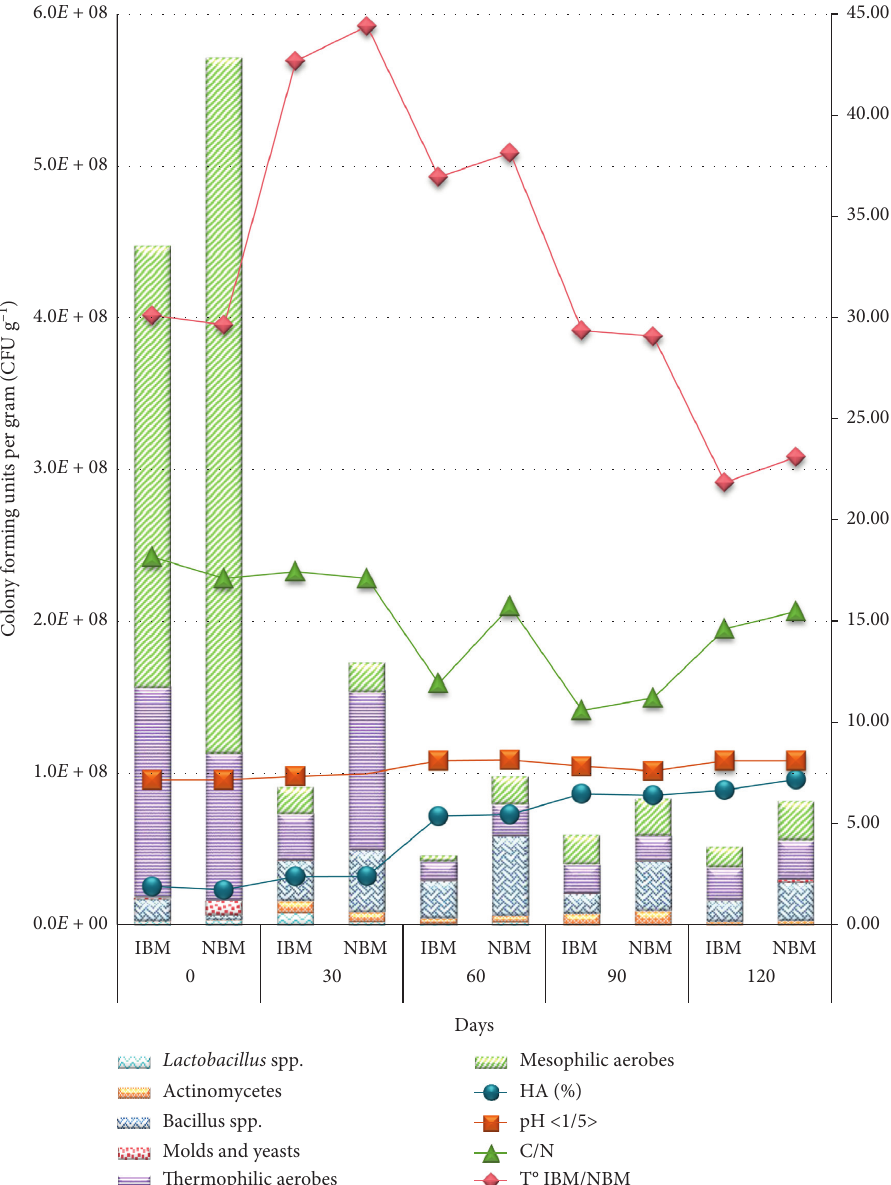
Figure 5: Microbiological variables counted as colony-forming units per Gram (CFU · g − 1 ) during composting of cow manure and tree litter in inoculated (IBM) and noninoculated (NBM) piles and physicochemical variables (HA, pH, C/N ratio and T ° ). ∗ For the purposes of the composition of the figure, the data for molds and yeasts on day 0 in the noninoculated piles (NBM) were divided by